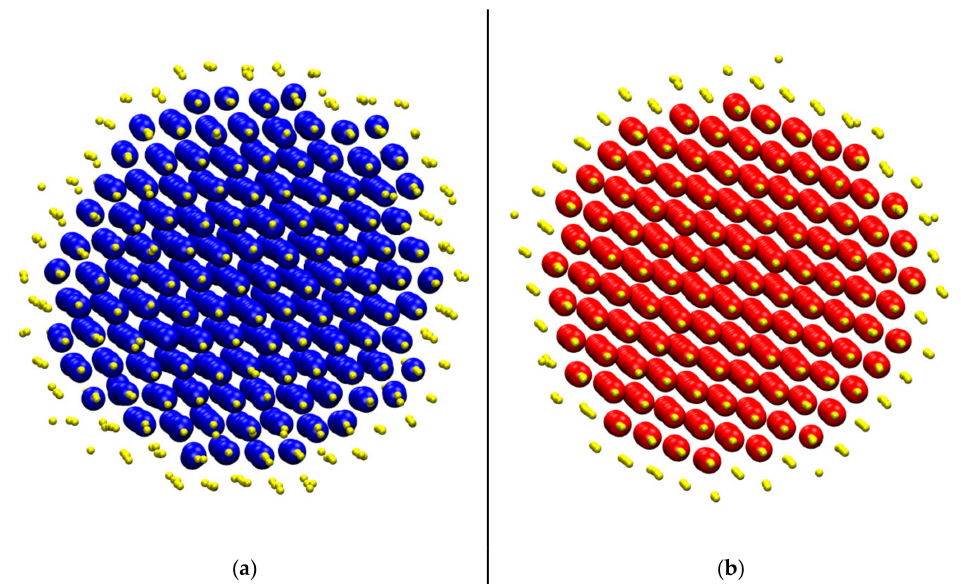
Figure 6. Snapshots at the end of NVT MC simulations on SW chains ( N av = 24). ( a ) ε = 0.5 and σ 2 = 2.0; ( b ) ε = 0.5 and σ 2 = 2.3. Spheres are color-coded according to the X -crystal similarity ( ε X < ε thres = 0.245) as identified by the value of the CCE norm. Blue, red, green, purple and cyan colors correspond to HCP, FCC, FIV, HEX and BCC crystals, respectively. Crystal sites are shown with reduced diameter in a 3:5 scale. Amorphous (or unidentified) sites are shown in yellow color and reduced (1:5) diameter for visualization purposes. Image created with the VMD software. Each figure panel is also available as stand-alone image in 3-D, interactive format in the Supplementary Materials.